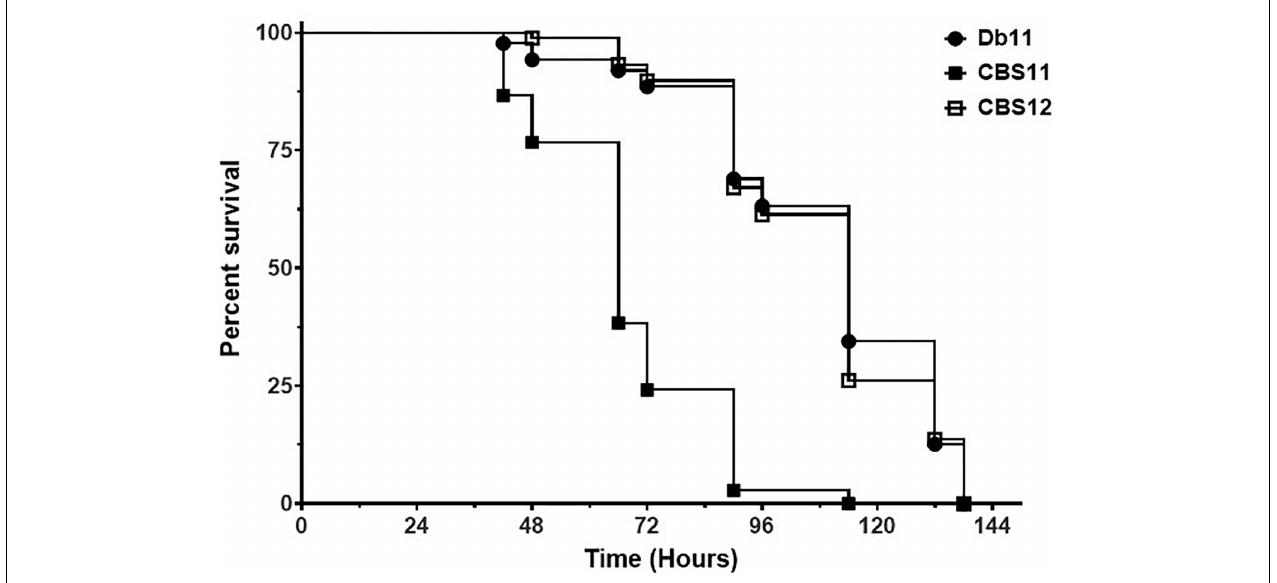
FIGURE 2 | Survival of C. elegans on S. marcescens strains. Kaplan-Meier survival curve of C. elegans N2 nematodes fed Db11 (black circle, n = 90), CBS11 (black square, n = 90, p < 0.001), and CBS12 (open square, n = 90, p = 0.700). Survival curve is representative of one of three independent